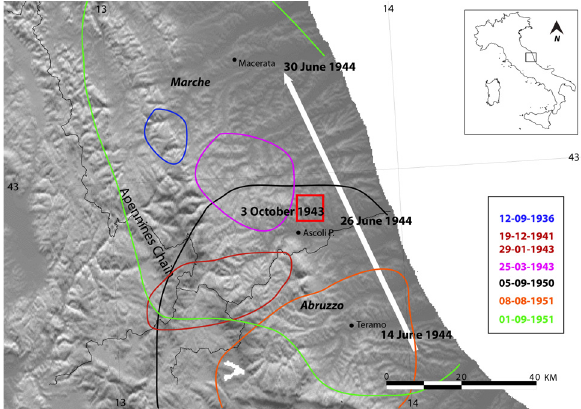
Figure 6. Location of the October 3, 1943 event (red square) with re- spect to the areas affected by damage caused by other earthquakes oc- curred in the region between 1936 and 1951 (indicated with colors in legend). The white arrow shows the progress of the war front line be- tween 1943 and 1945, with the liberation dates for Teramo, Ascoli Pi- ceno and Macerata.